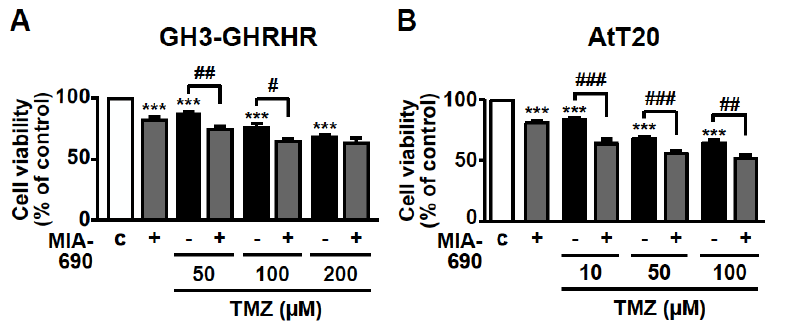
indicated. Results, expressed as percent of control, are means ± SEM of three replicates. *** p < 0.001 vs. c; # p < 0.05, ## p < 0.01, ### p < 0.001 by one-way ANOVA followed by Tukey’s multiple comparison post-hoc test ( n =